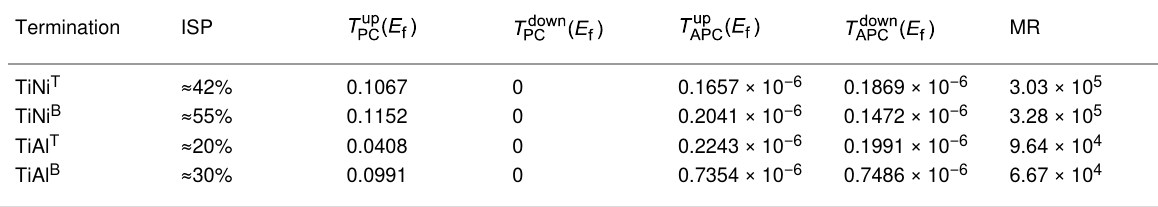
Table 1: The calculated interface spin polarization (ISP), transmission coefficients at the Fermi level, and magnetoresistance ratio (MR) of the Ti 2 NiAl/ Ag/Ti 2 NiAl device with various atomic